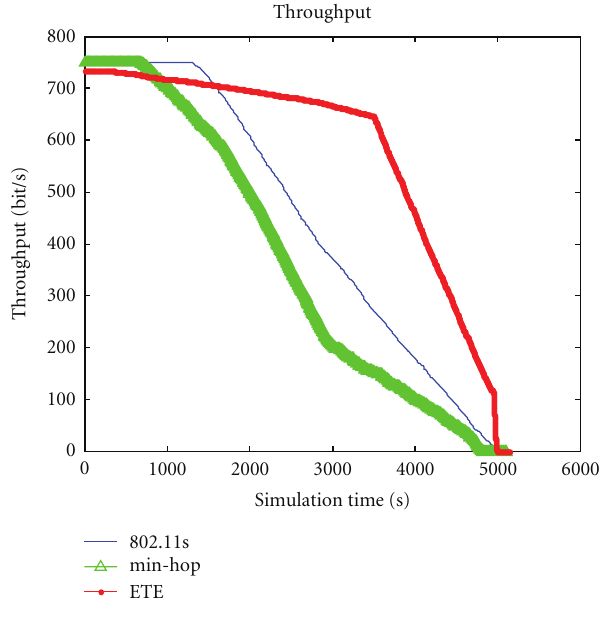
Figure 6: Throughput of